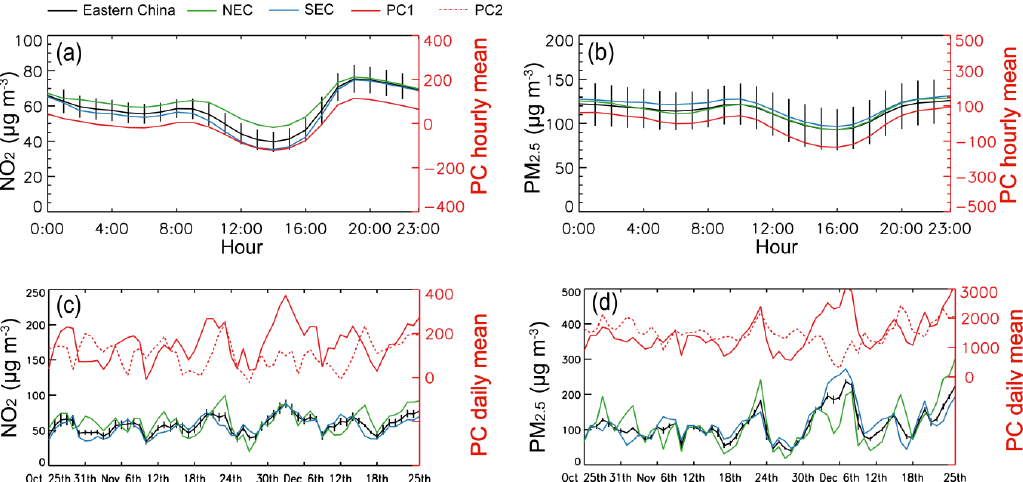
Figure 6. (a) Diurnal variation of observed NO 2 averaged over 25 October–25 December 2013. The black vertical bars represent 1 standard deviation across the days. PC1 from the EOF analysis is overlaid in red. (b) Similar to (a) but for PM 2 . 5 . (c) Day-to-day variation of daily mean NO 2 over 25 October–25 December 2013. Data are de-trended. The black vertical bars represent 1 standard deviation due to the diurnal variation. PC1 and PC2 from the EOF analysis are overlaid in red. (d) Similar to (c) but for PM 2 . 5 .